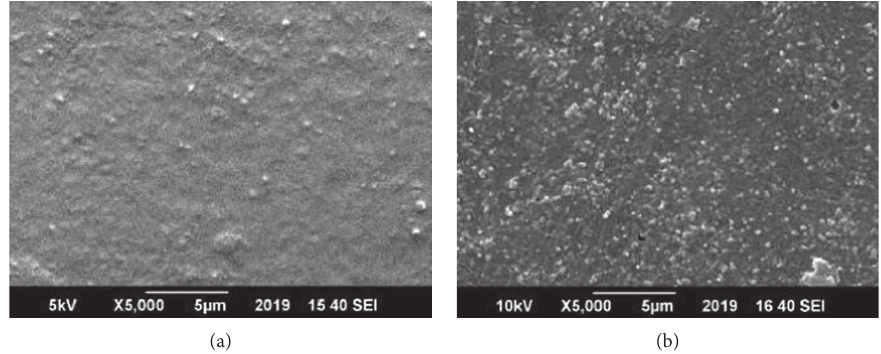
Figure 22: SEM images of (a) PVA (L+H) and (b) 5% ginger-loaded PVA (L+H) film.